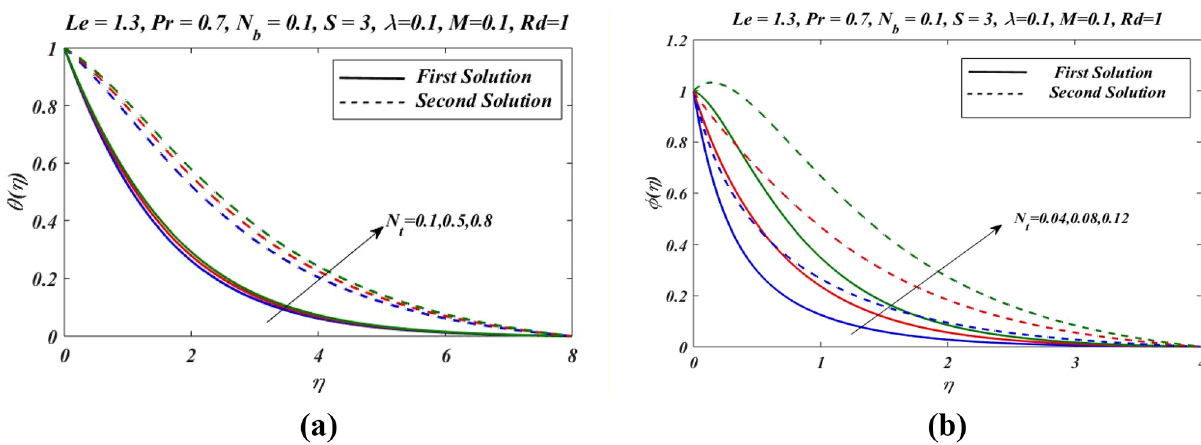
Figure 8. Outcomes of N t on ( a ) temperature and ( b ) nanoparticles volume fraction.